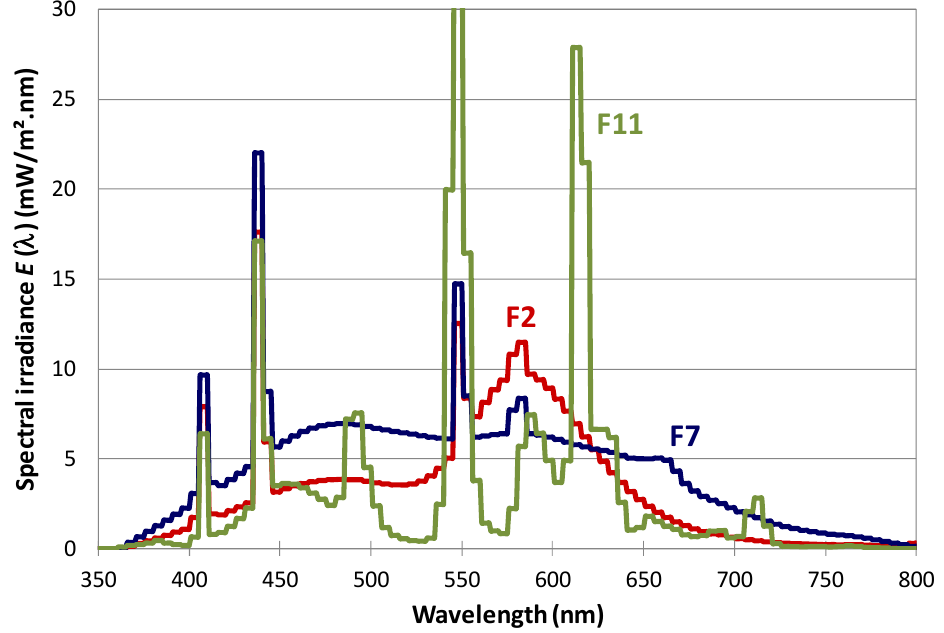
lighting, scaled to 500